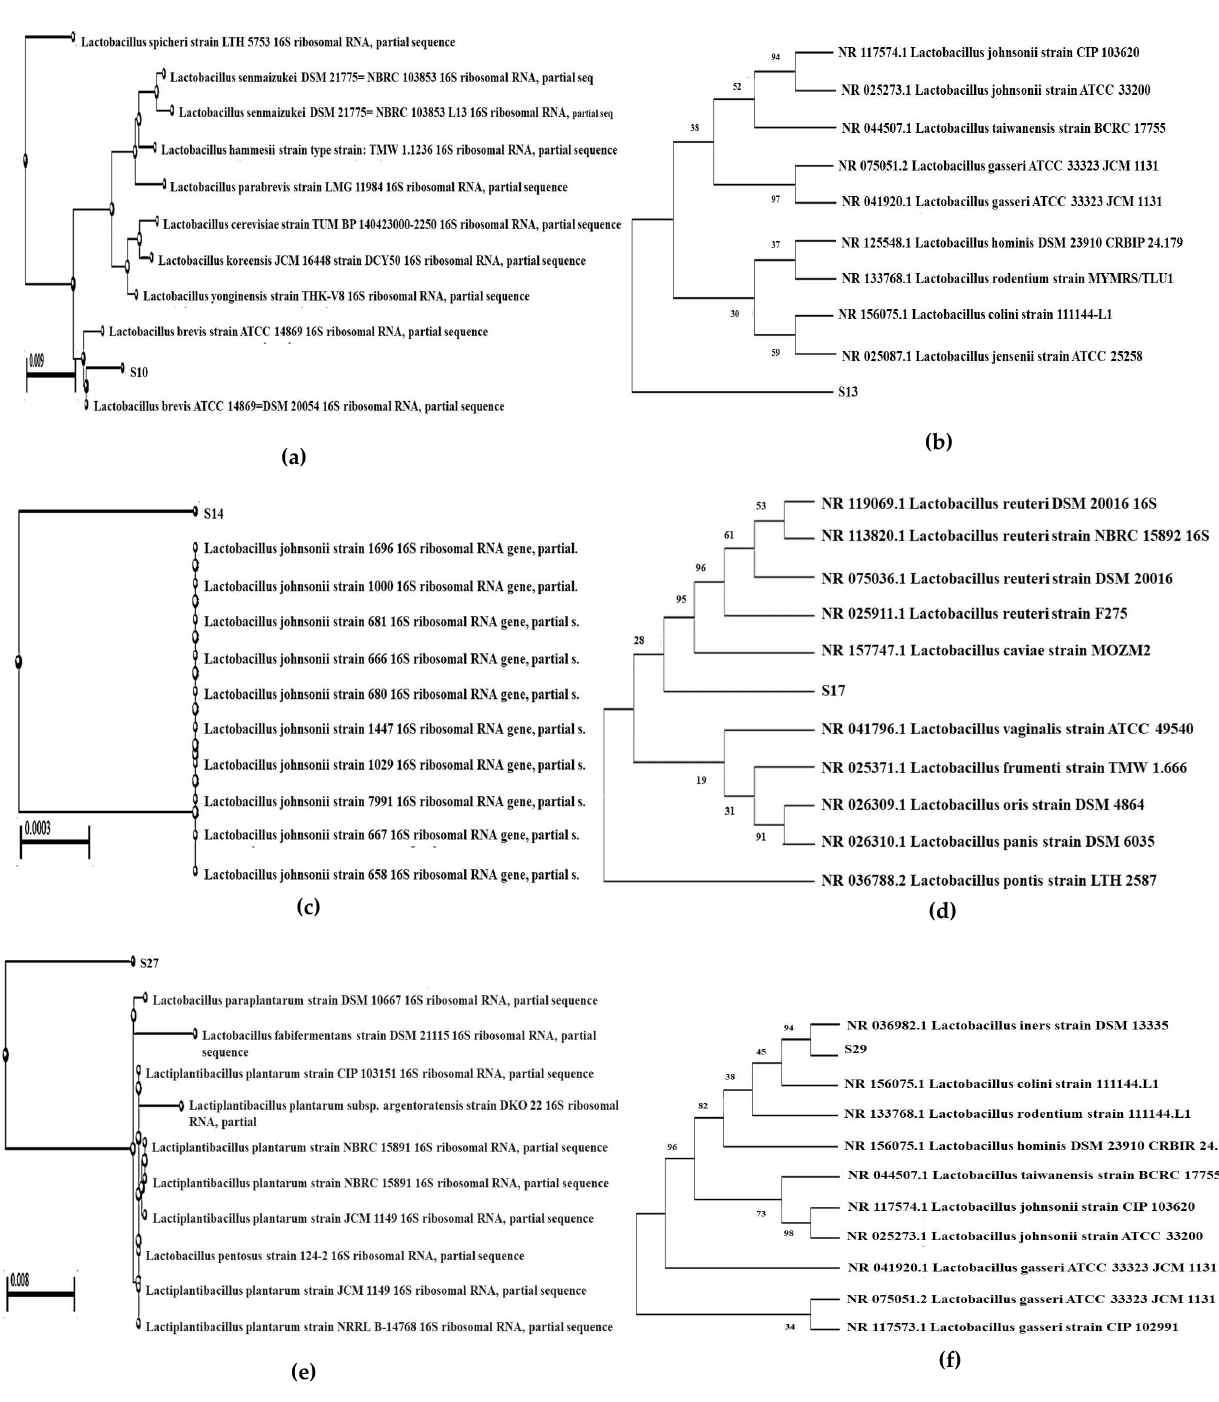
Figure 8. Dendogram showing the homology of six LAB strains ( a ) S10; ( b ) S13; ( c ) S14; ( d ) S17; ( e ) S27; ( f ) S29, with 51 strains representing the genera Lactobacillus .